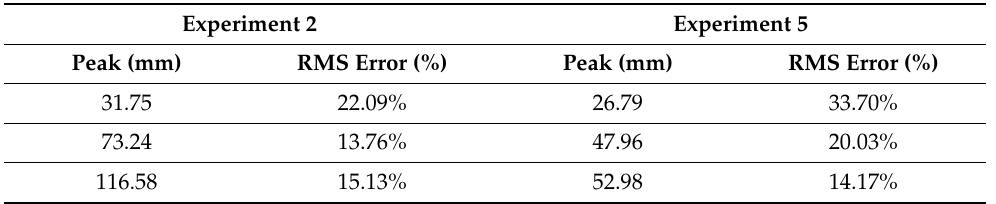
Table 2. Error summaries of